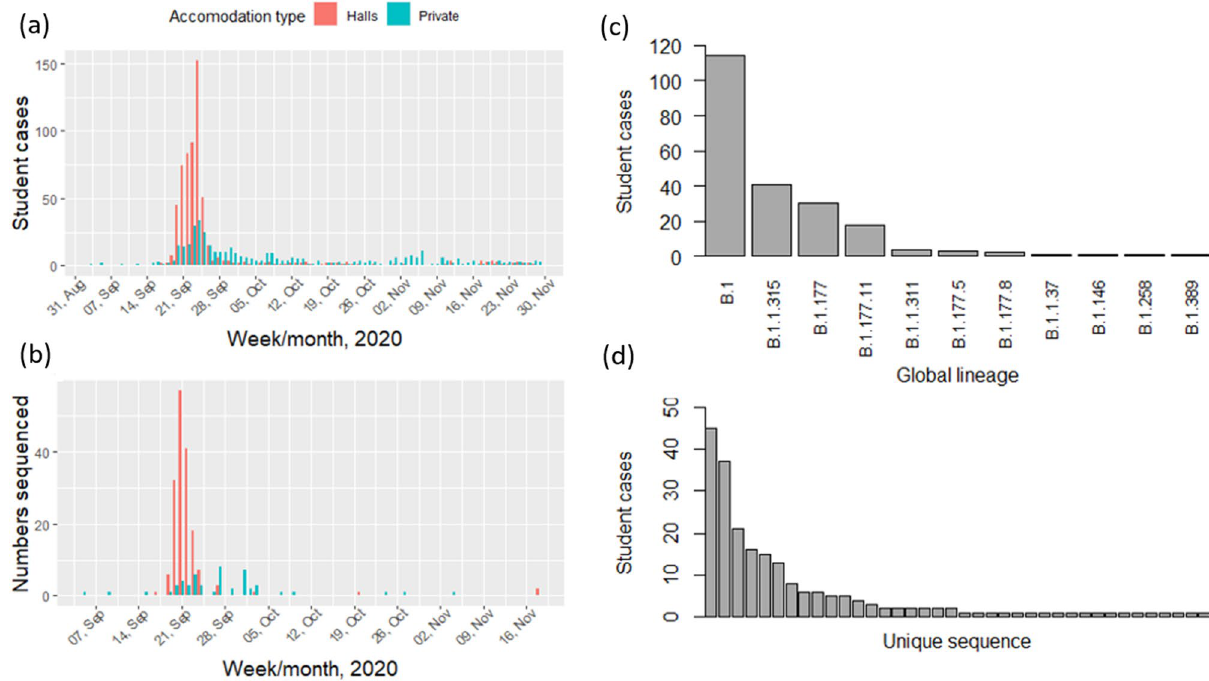
Figure 1. ( a ) Numbers of University of Glasgow student cases identified from contact tracing information over time, and ( b ) for the subset with sequenced samples, according to university residential halls or private accommodation. ( c ) Frequency distributions of SARS-CoV-2 lineages and ( d ) unique sequences identified among the student